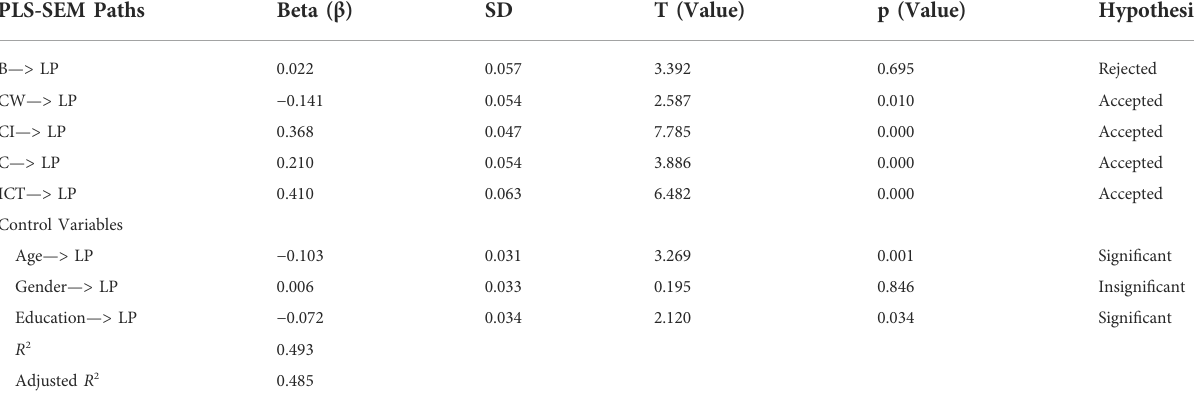
TABLE 5 Path analysis (PLS-SEM).